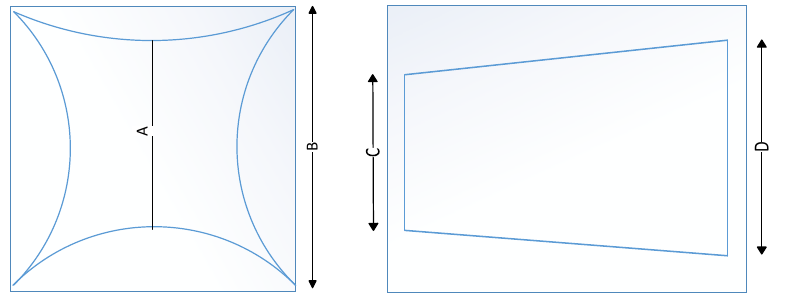
Figure 3. Distortion graphic outline (left: pillow distortion schematic; right: skew distortion schematic). The pillow distortion rate and the tilt distortion rate can be calculated as follows: